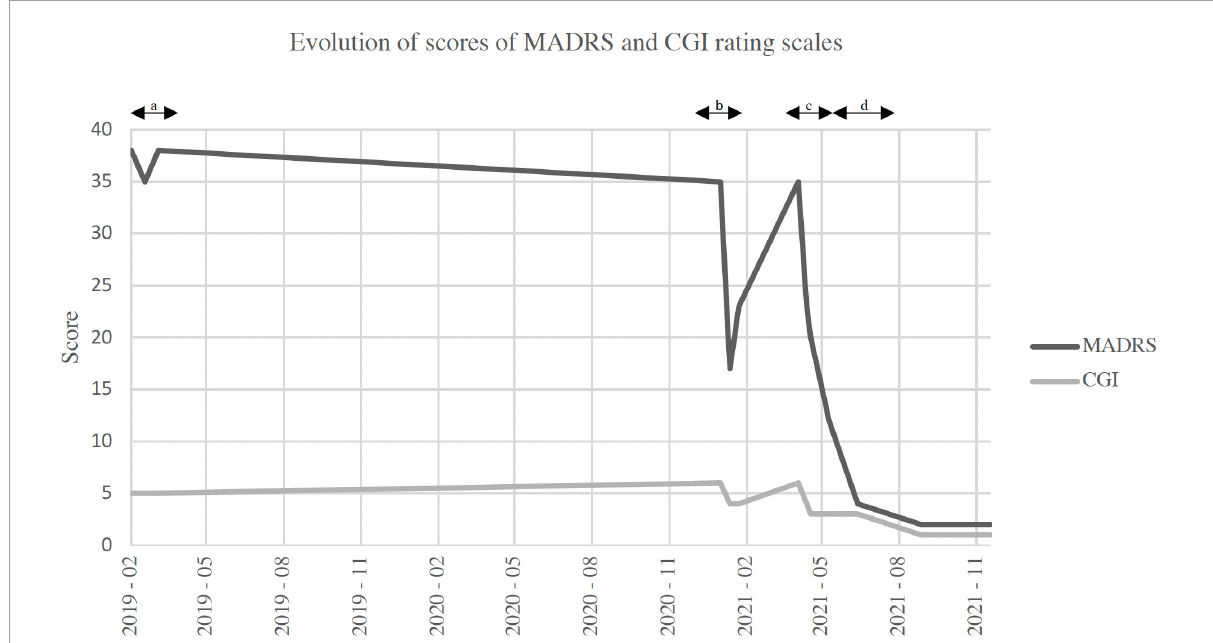
FIGURE2 Evolution of scores of Montgomery-Asberg depression rating scale (MADRS) and clinical global impression (CGI) rating scales. (A) Duration of repetitive transcranial magnetic stimulation (rTMS) monotherapy. (B) Duration of ketamine monotherapy. (C) Duration of combination induction phase. (D) Duration of combination consolidation phase. MADRS, Montgomery-Asberg depression rating scale; CGI, clinical global impressions scale.